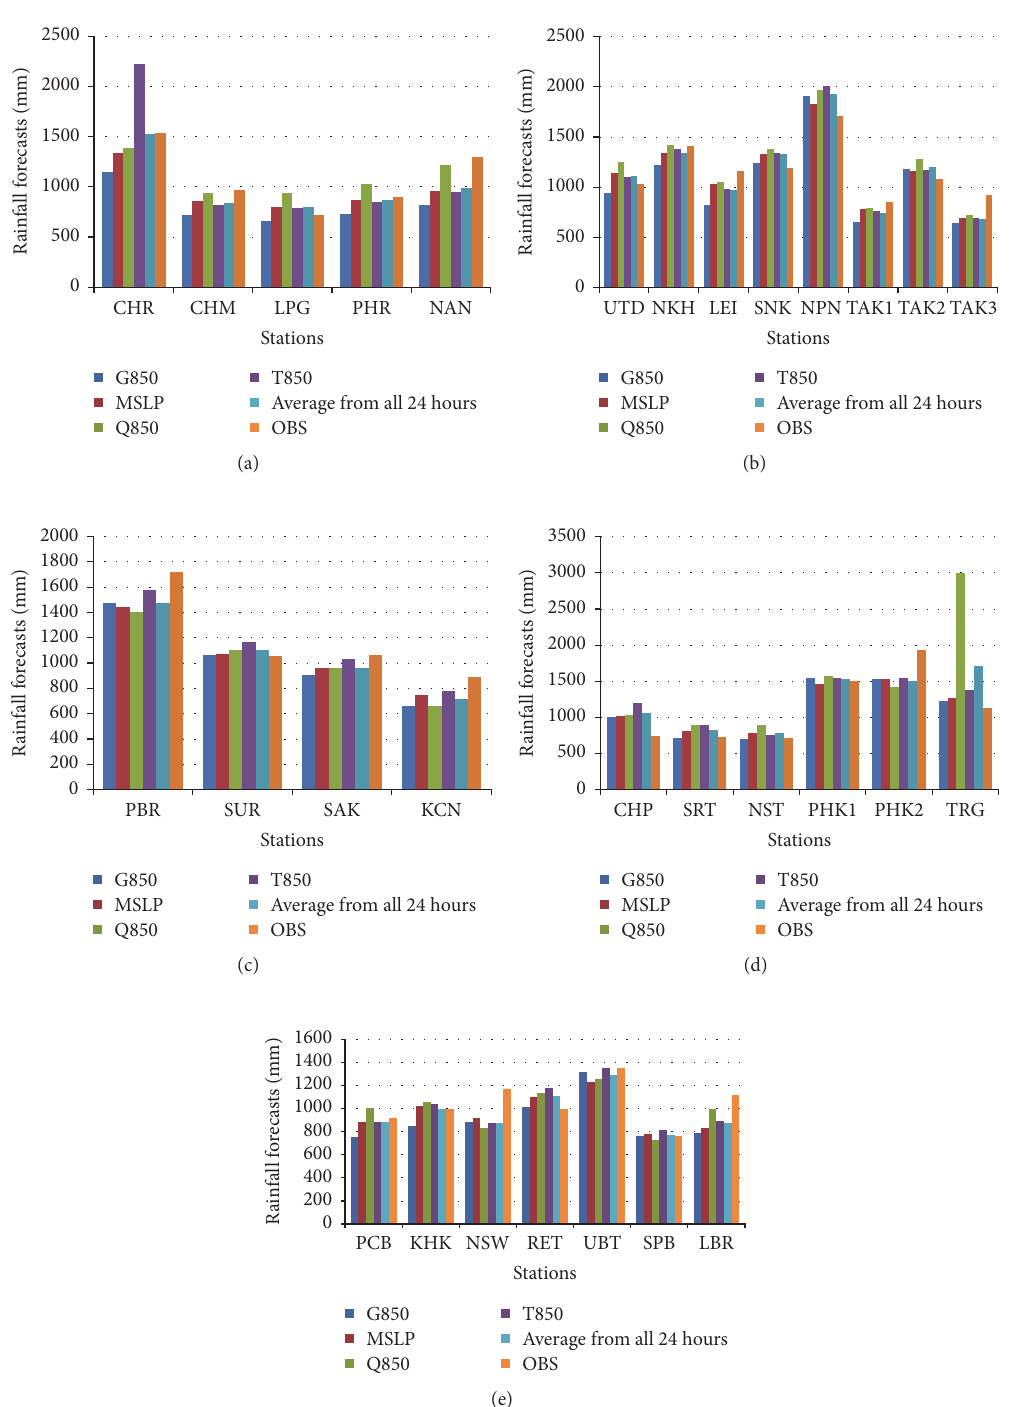
Figure 12: The histogram of the comparison between observed stations and simulations for four predictors, represented by an average from all 24 hours, mean sea level pressure, temperature, moisture, and geopotential height at 850 hPa of MCAM decomposition. This study shows five provinces: (a) northern, (b) northeast, (c) western, (d) southern, and (e)